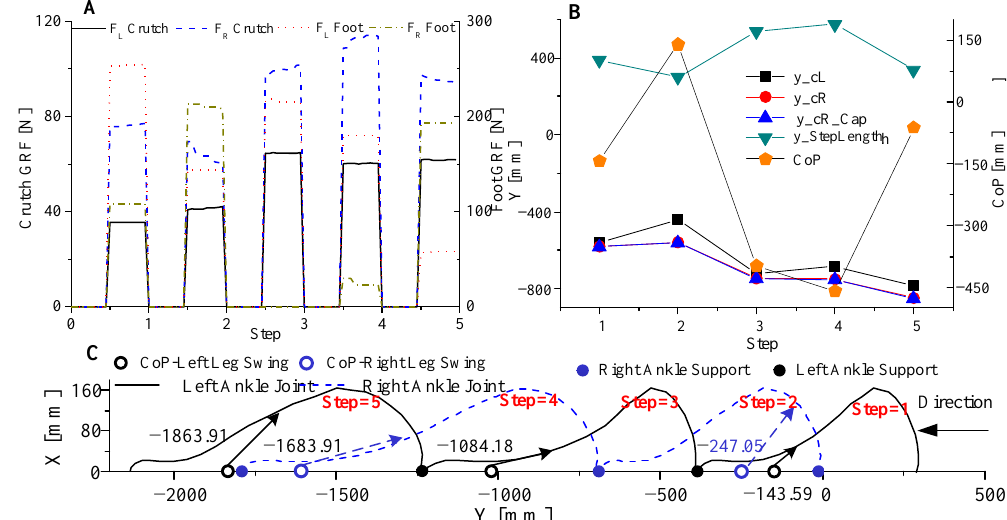
Figure 12. Intermediate variables and L / R ankle joint trajectories. ( A ) Sampled and preprocessed L / R crutches and exoskeleton sole GRFs before the swing phase, representing contributions for human-machine support. GRFs during the other phases were set to 0 here for clarity. ( B ) Calculation results of L / R crutch endpoint coordinates (y_cL and y_cR), step length, combined CoP coordinates, and right crutch endpoint coordinate from the motion capture system (y_cR_Cap), representing bases of the bgait planning algorithm. ( C ) L / R ankle joint Cartesian position coordinates and corresponding combined CoP (hollow circle) and support ankle joint (solid circle). The arrows indicate the corresponding relationship between CoP and ankle joint Cartesian position. Except for step 2, each CoP was outside L / R legs before the swing, and finally located within L / R legs after the swing as shown here.